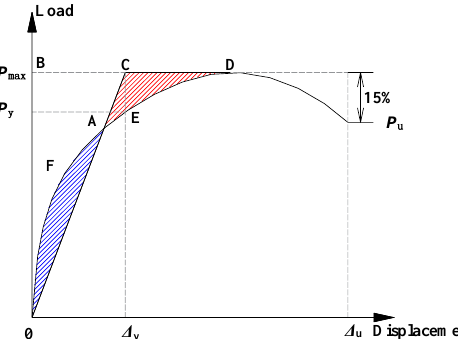
Figure 10. Method used to define yield and ultimate displacements.